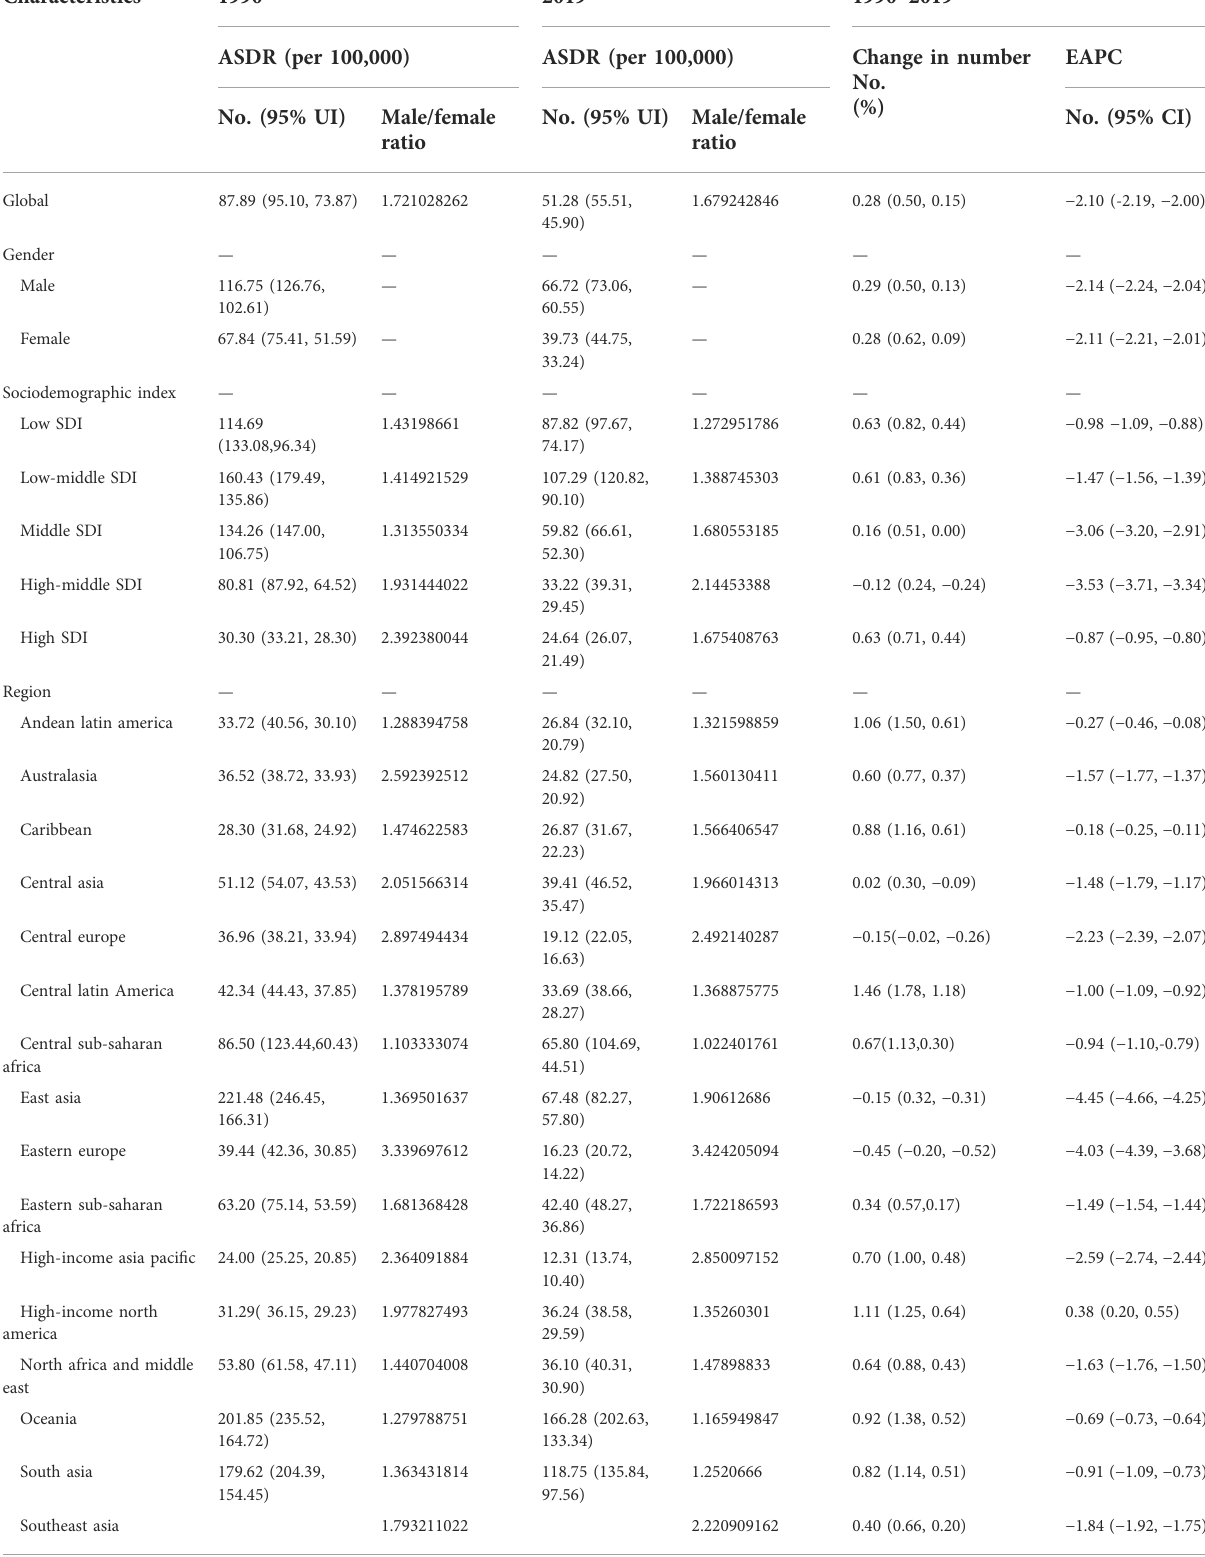
TABLE 2 The age-standardized death rate (ASDR) of chronic obstructive pulmonary disease in 1990 – 2019 and its temporal trends.